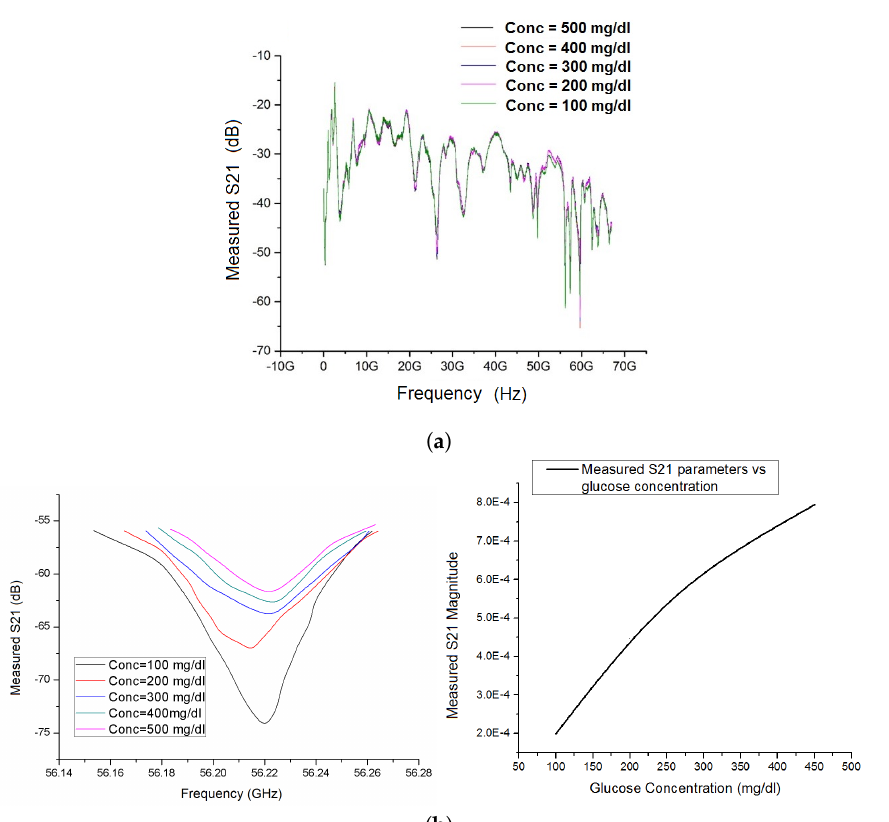
Figure 4. S-parameters measured using Keysight Signal Analyzer N9030A: ( a ) measured S21 from 1 GHz to 67 GHz; ( b ) measured S21 parameters focused in the neighborhood of 56 GHz ( left ), and measured S21 parameters as a function of glucose concentration at 56.2 ( right